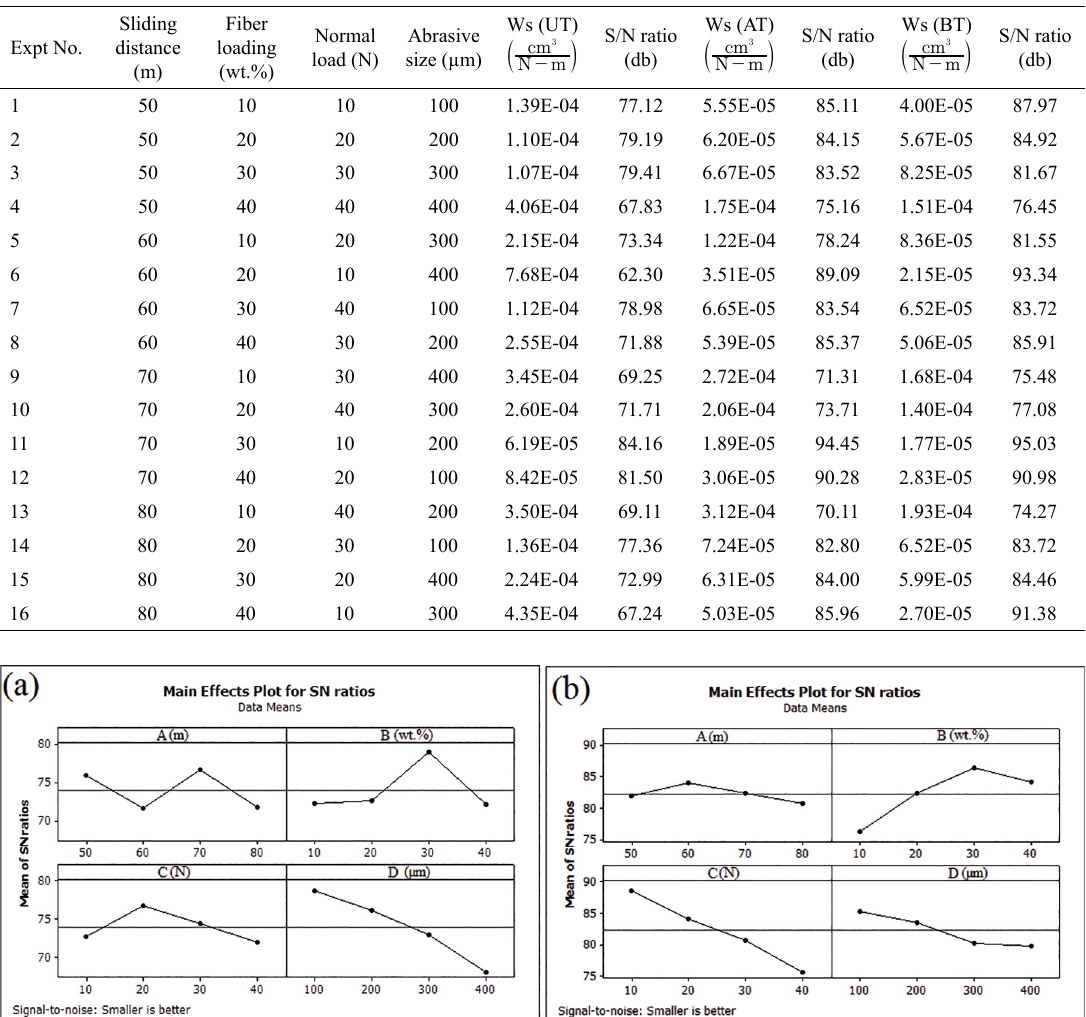
orthogonal array 16